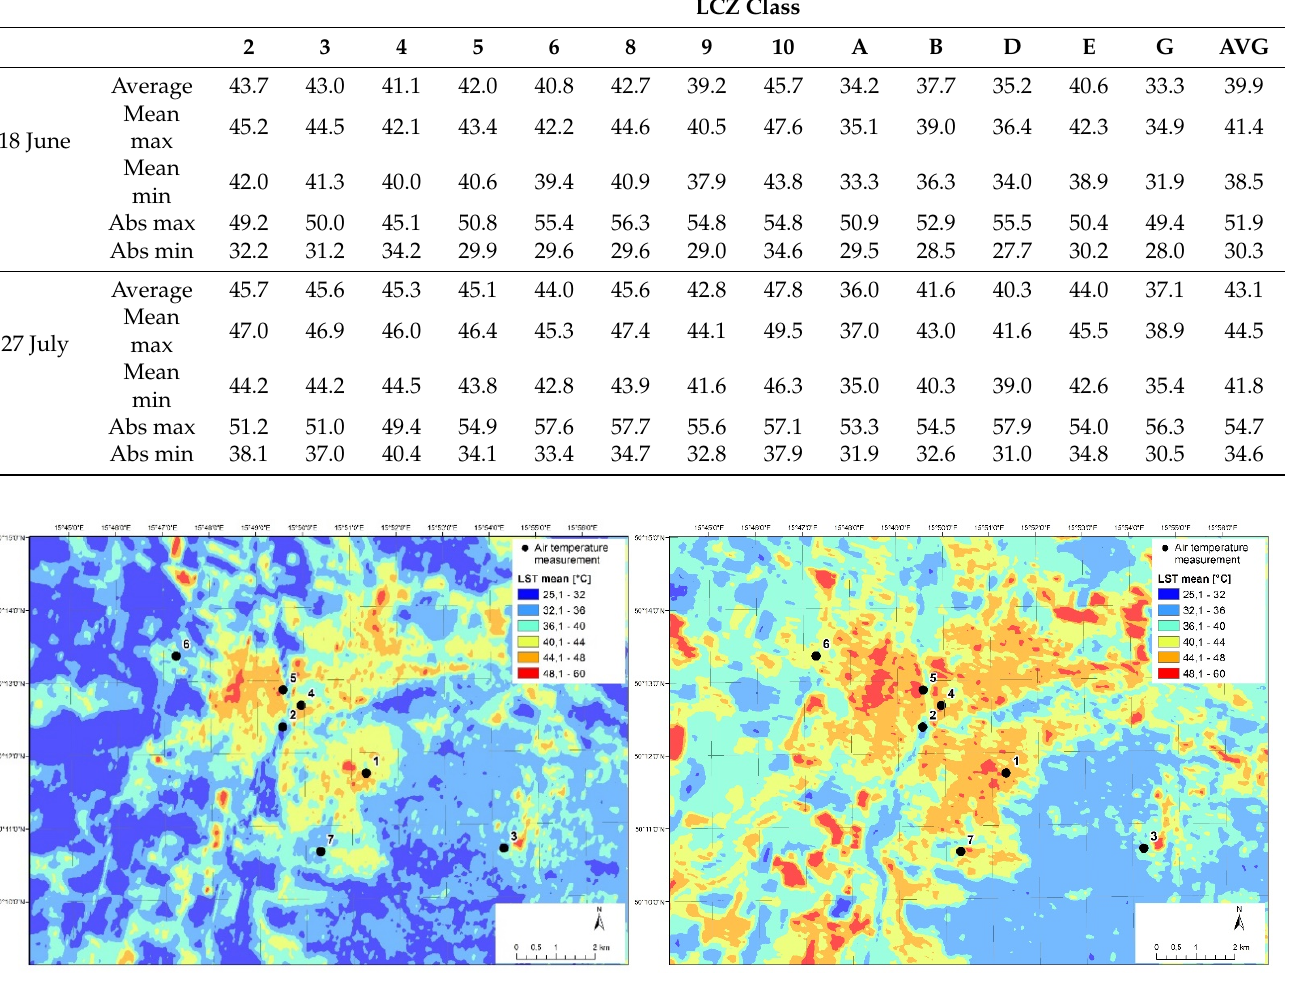
Table 4. LST (°C) in LCZ classes in study area. LCZ Class 2 34.6 The highest June average LST and mean maximum LST correspond to LCZs 10, 2, 3 and 8 (Table 4; Figure 6A,B), i.e., land cover with distinct prevalence of artificial surfaces (heavy industry, compact mid-rise, compact low-rise, large low-rise). It testifies also a cluster of these LCZs on the dendrogram of cluster analysis on Figure 6D. Cluster analysis is the task of grouping a set of objects in such a way that objects in the same cluster are more similar (in some sense) to each other than to those in other clusters. Analogously, another cluster is formed by LCZs A, G, D (dense trees, water, low plants) which signifi- cantly differs from all remaining LCZs in June.